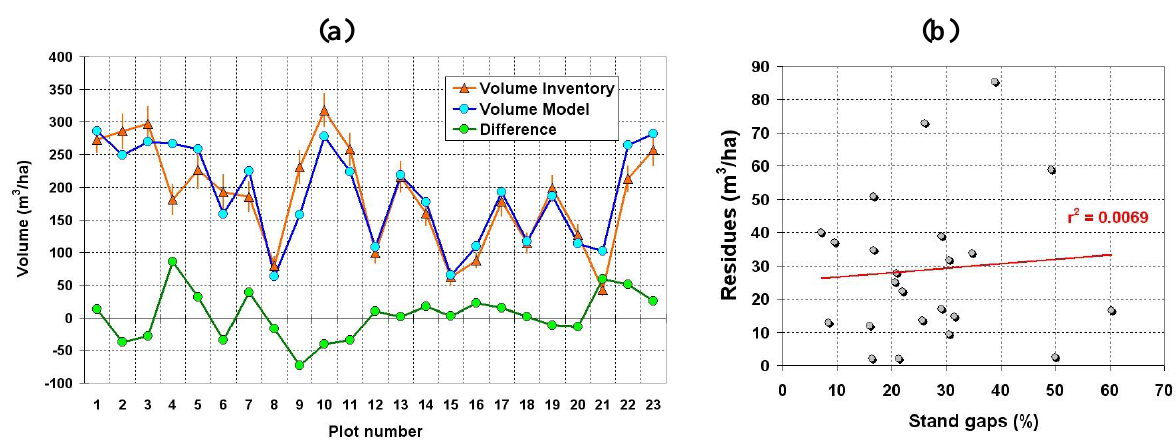
Figure 9. (a) Comparative graph between inventory volume, volume regression model results and difference between the ground truth and the model (Difference); (b) graphic of regression residues and percentage of stand